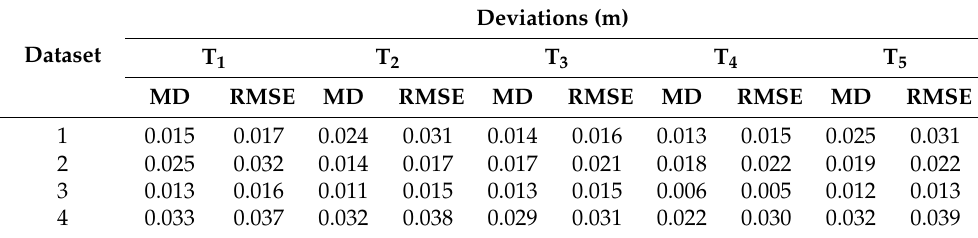
Table 6. The deviations in the diameter at breast height (DBH) values. ‘Ti’ represents a single TLS point cloud, ‘MD’ represents the mean absolute deviation, and ‘RMSE’ is the root mean square error of the DBH